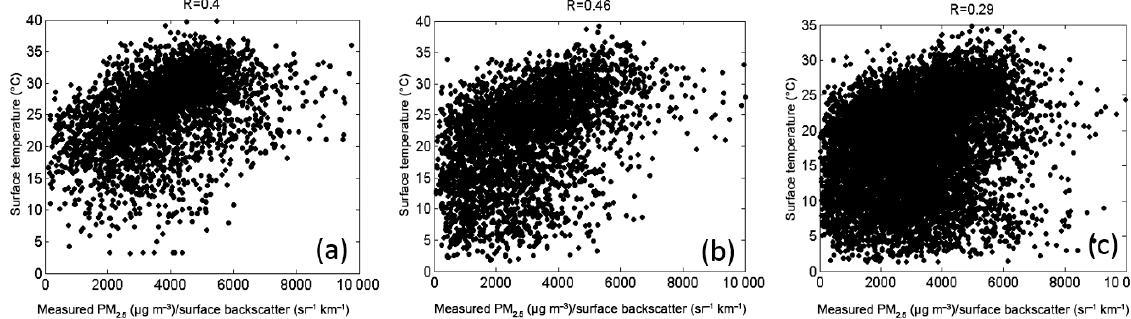
Figure 4. The relationship between surface temperature and PM2.5/backscatter ratio for (a) daytime clear-sky cases, (b) daytime cloudy cases and (c) nighttime cases.